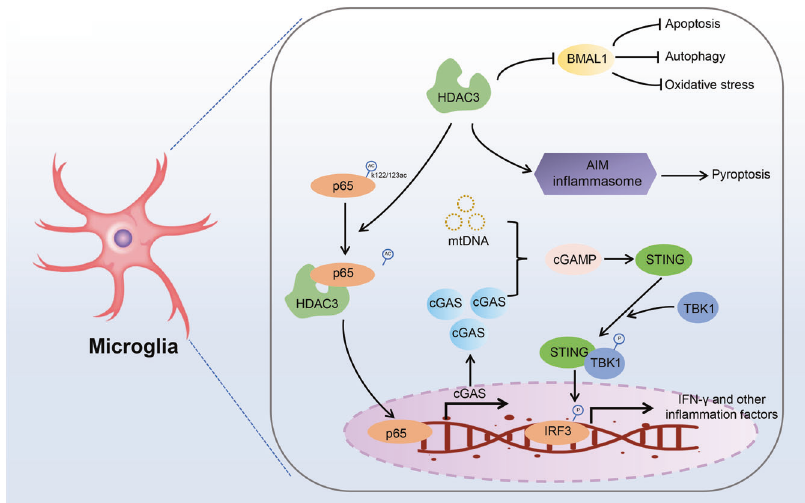
Fig. 4 The role of HDAC3 in brain injury. HDAC3 promotes neuronal cell death via multiple mechanisms. HDAC3 is upregulated in microglia after ischemia stimulation, deacetylating p65 at K122. Deacetylated p65 translocates into the nucleus activating the transcription of cGAS. Ischemia-induced mitochondrial DNA is recognized by cGAS, which activates the microglial cGAS-STING-IRF3 pathway and promotes neuroin fl ammation. In addition, HDAC3 inhibits the activation of the AIM in fl ammasome and induces pyroptosis. HDAC3 also induces apoptosis, autophagy, and oxidative stress by inhibiting the expression of